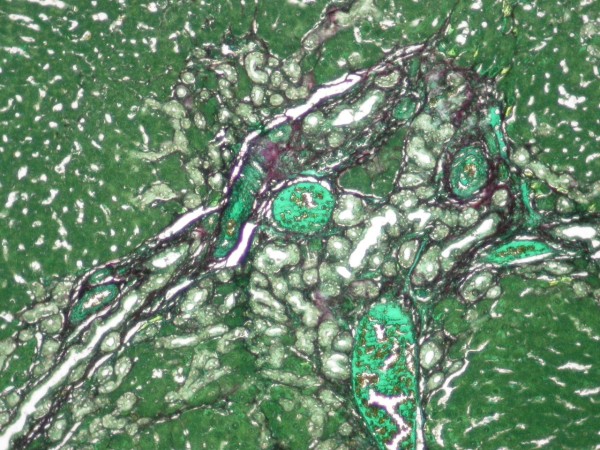
Sirius red and fast green-stained liver sections showed prominent bile duct proliferation and fibrosis (× 20). Sirius red stained collagenous proteins. Fast green stained non-collagenous proteins.